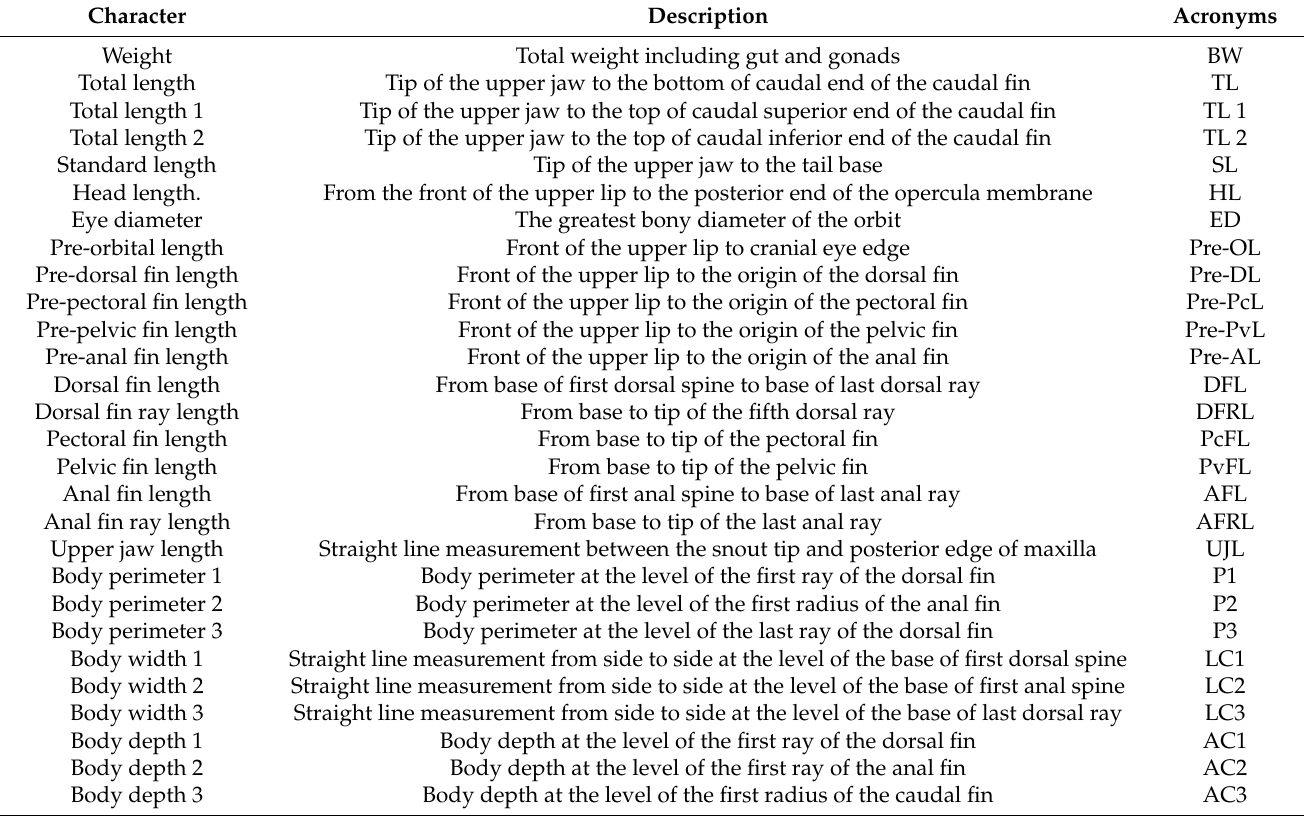
Table 1. Morphometric measurements used in this